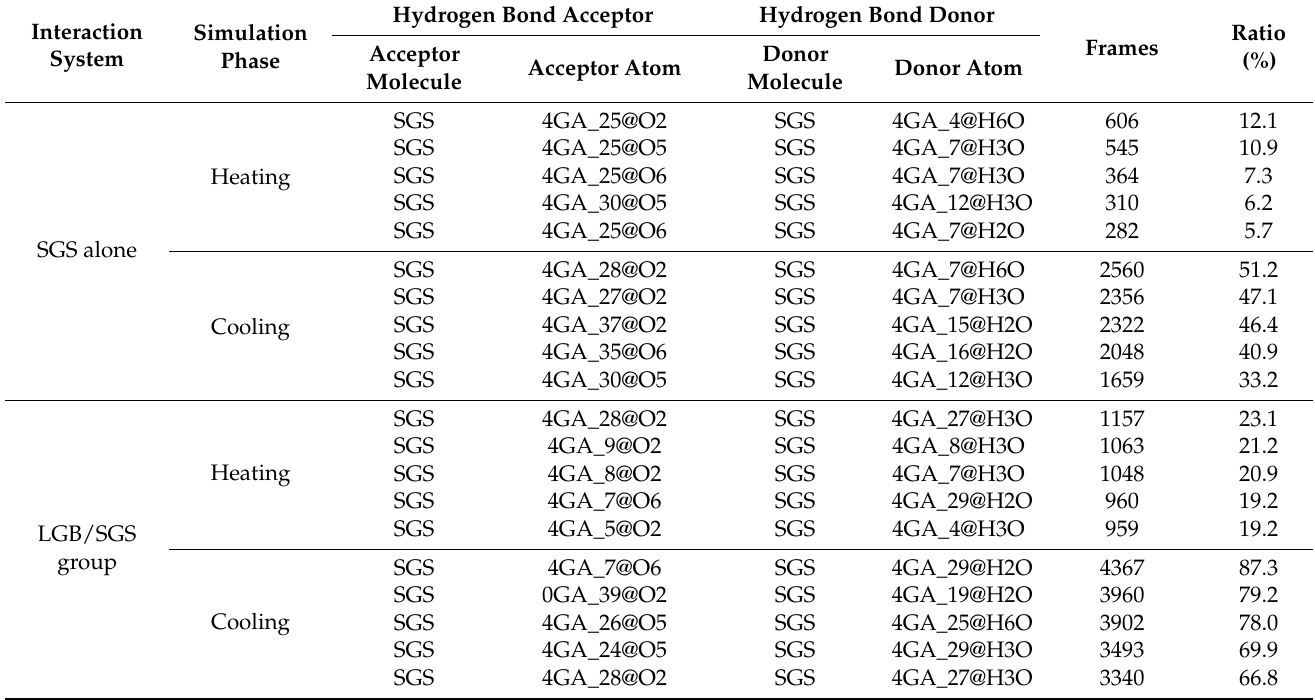
Table 3. The intramolecular hydrogen bonds within two SGS chains in different interaction